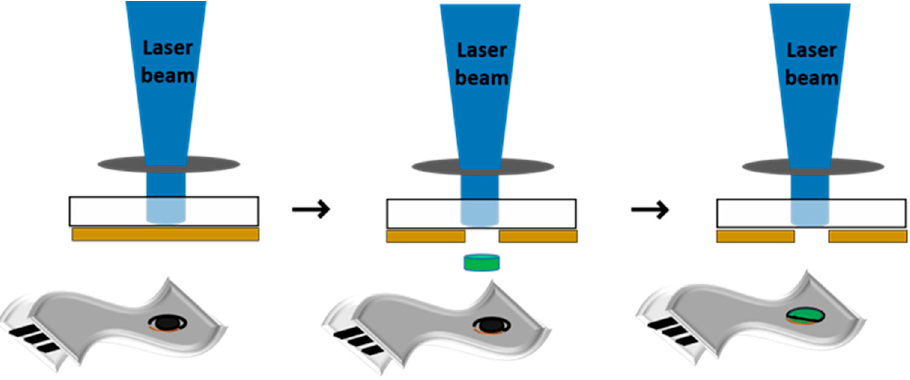
Figure 1. Scheme of the LIFT process for printing SnO 2 and Pd-SnO 2 pixels from SnCl 2 (acac) 2 and Pd-SnO 2 donors onto flexible electrochemical electrodes.